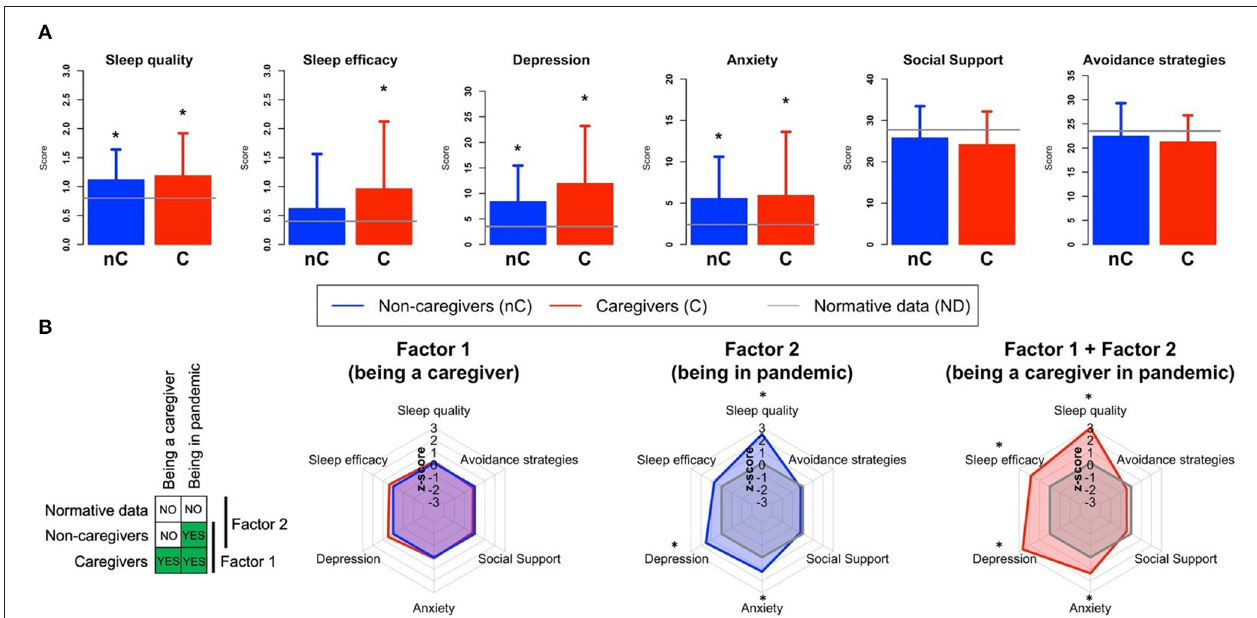
FIGURE 2 | (A) Comparisons between caregivers (C), non-caregivers (nC) for PSQI-Sleep Quality Perception, PSQI-Sleep Efficiency, DASS-Depression, DASS-Anxiety, COPE-NVI-Social Support and COPE-NVI-Avoidance Strategies scores. Dashed lines indicated normative data (ND) level for each component. Higher values for the PSQI quality perception and efficiency scores mean worse performance (bad quality perception and bad habitual efficiency). *significant difference with the normative data. (B) Radar plots show the results of the investigation of the role of different components of caregivers’ stress on depression, anxiety, sleep abnormalities and coping strategies in T2. Factor 1 (being a caregiver) was analyzed by comparing caregivers and non-caregivers (both in pandemic). Factor 2 (being in a pandemic) was investigated by comparing non-caregivers with normative data (i.e., not collected during a pandemic). Finally, we investigated both Factor 1 and Factor 2 (being a caregiver in pandemic) by comparing caregivers and normative data. The radar plots show the comparison between two groups, with one group used as reference (i.e., the scores of one group were z-scored on the reference group). For Factor 1 the non-caregivers were the reference group, for Factor 2 and 3 we used the normative data as